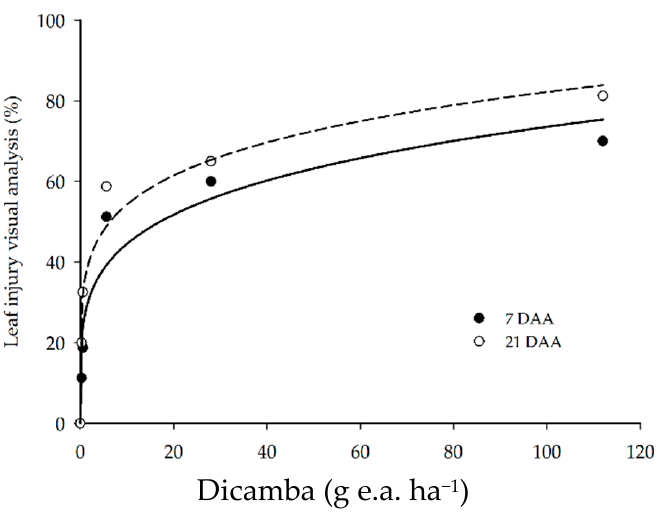
Figure 2. Visual analysis of soybean leaf injury at 7 and 21 DAA of dicamba doses. Dicamba is a systemic herbicide, absorbed and translocated to growth points in the plant. The phytotoxic symptoms usually arise at approximately 7 DAA and tend to increase up to 21 to 28 DAA [26,27]. The main symptoms observed were the curling and wrinkling of younger leaves. At higher doses, reductions in plant height were found, and, at the highest dose (112 g e.a. ha − 1 ), stem twist and death of the apical meristem were observed. Other studies reported similar results, since the application of extremely low dicamba doses (<1 g e.a. ha − 1 ) are capable of causing visible injury in soybean plants [4,28]. These results corroborate the meta-analysis conducted by Kniss [8], who estimated the dose of 0.038 g ha − 1 dicamba as the lowest dose to cause 5% visual injury in